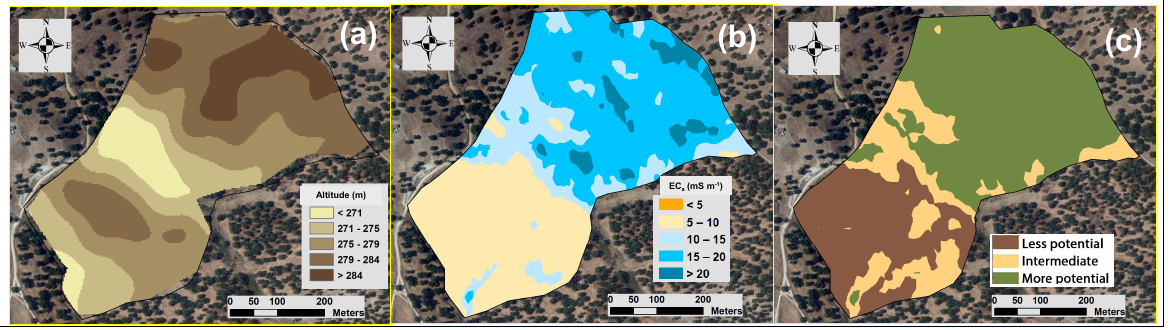
Figure 9. Altitude ( a ), soil apparent electrical conductivity (EC a ; ( b )) and homogeneous management zones ( c ) of “Murteiras” experimental field.